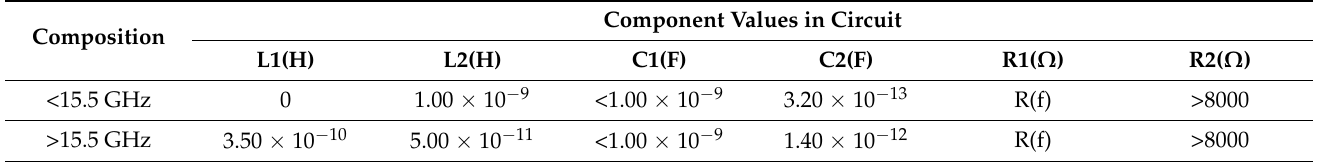
Table 6. New component values of the circuit model (composition C) in Figure 4 for frequency ranges <15.5 GHz and >15.5